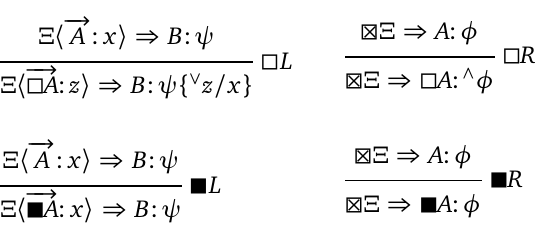
Figure 1: Normal modalities, where □ (cid:2) marks a structure all the types of which have main connective a